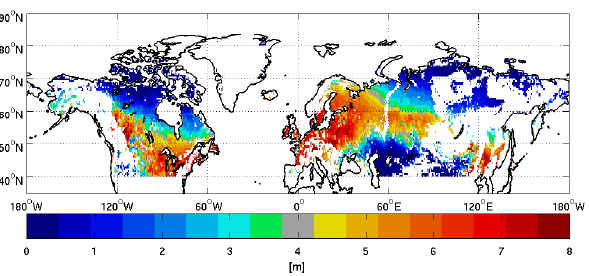
Fig. 7. Change in peat height between 8ka BP and 0ka.